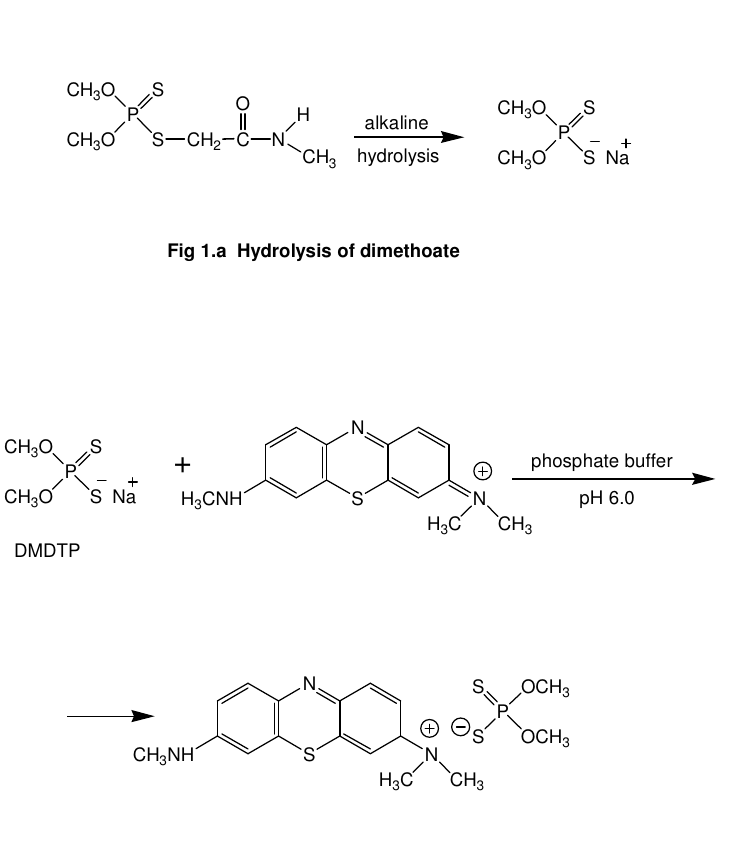
Fig 1.b Ion pair complex of dimethoate with